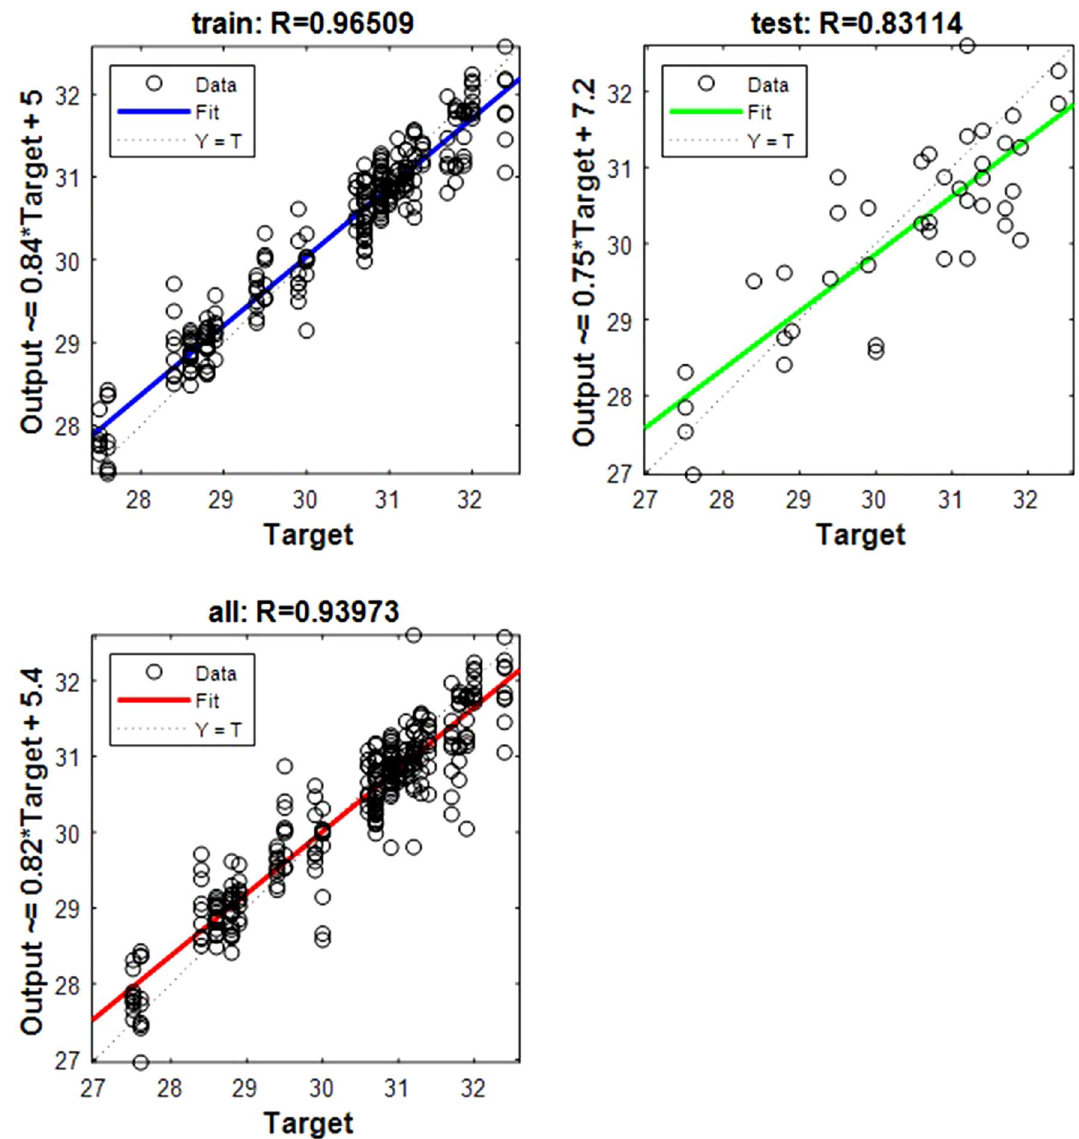
Figure 9. Represents the regression plot between the NIR-absorbance of spent dialysate and the MCH concentration in the patient blood at the beginning of the hemodialysis session (wavelength from 700–1700 nm, R all = 0.93, R train = 0.96, R test = 0.80, number of spectra used for training was N = 270). The MCH concentration in patients’ blood was 310 ± 7.54 (mean ± SD). The equation relating the predicted and measured values is Output = 0.82*Target + 5.4. Absorption spectra of the spent dialysate fluid for different values of hemoglobin concentration are shown in Fig.